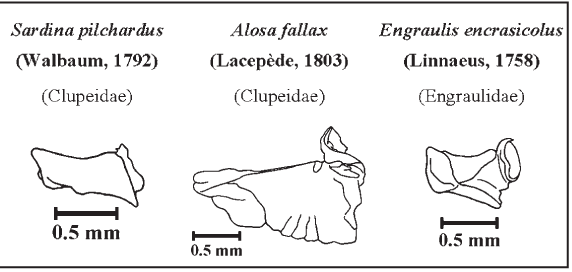
F IG . 7. – Ventral face of right, clupeiform type lapilli . All otoliths with lateral margin to the top of the page and anterior region to the